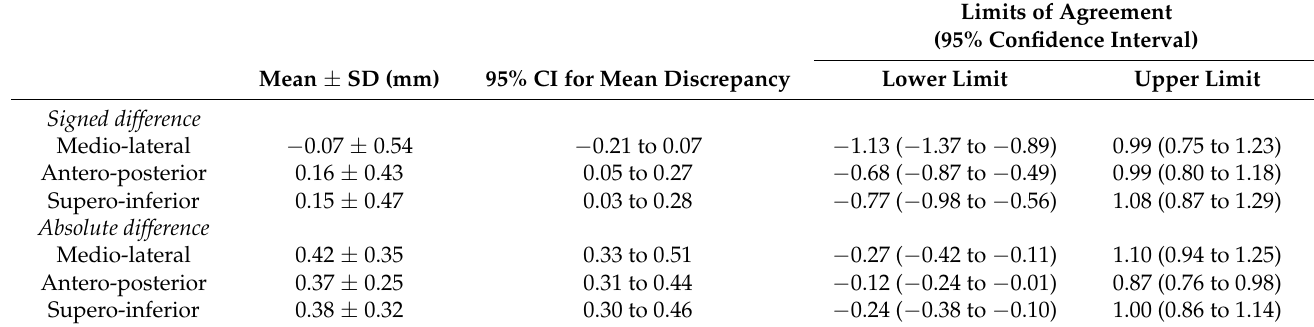
Table 5. Mean and standard deviation of discrepancy, 95% confidence intervals and limits of agreement for mean